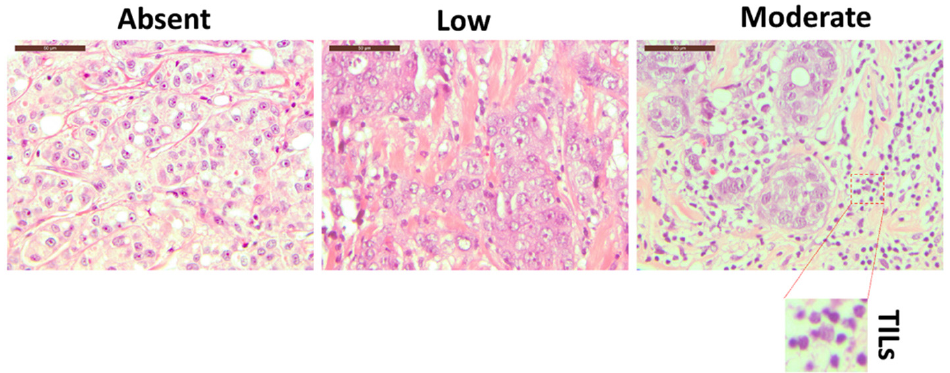
Figure 1. The hematoxylin–eosin staining of three different breast cancer tissue patients with three different level of TILs: absent (left panel), low (middle panel), and moderate (right panel). The inset represents an enlarged detail of the TILs. Magnification 40×. Scale bars 50 μ m.